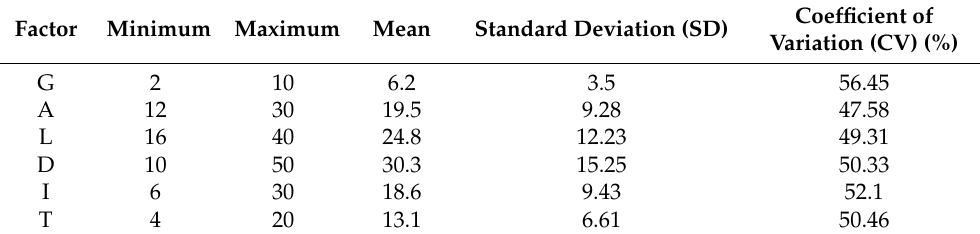
Table 5. Statistical summaries of GALDIT six parameters.